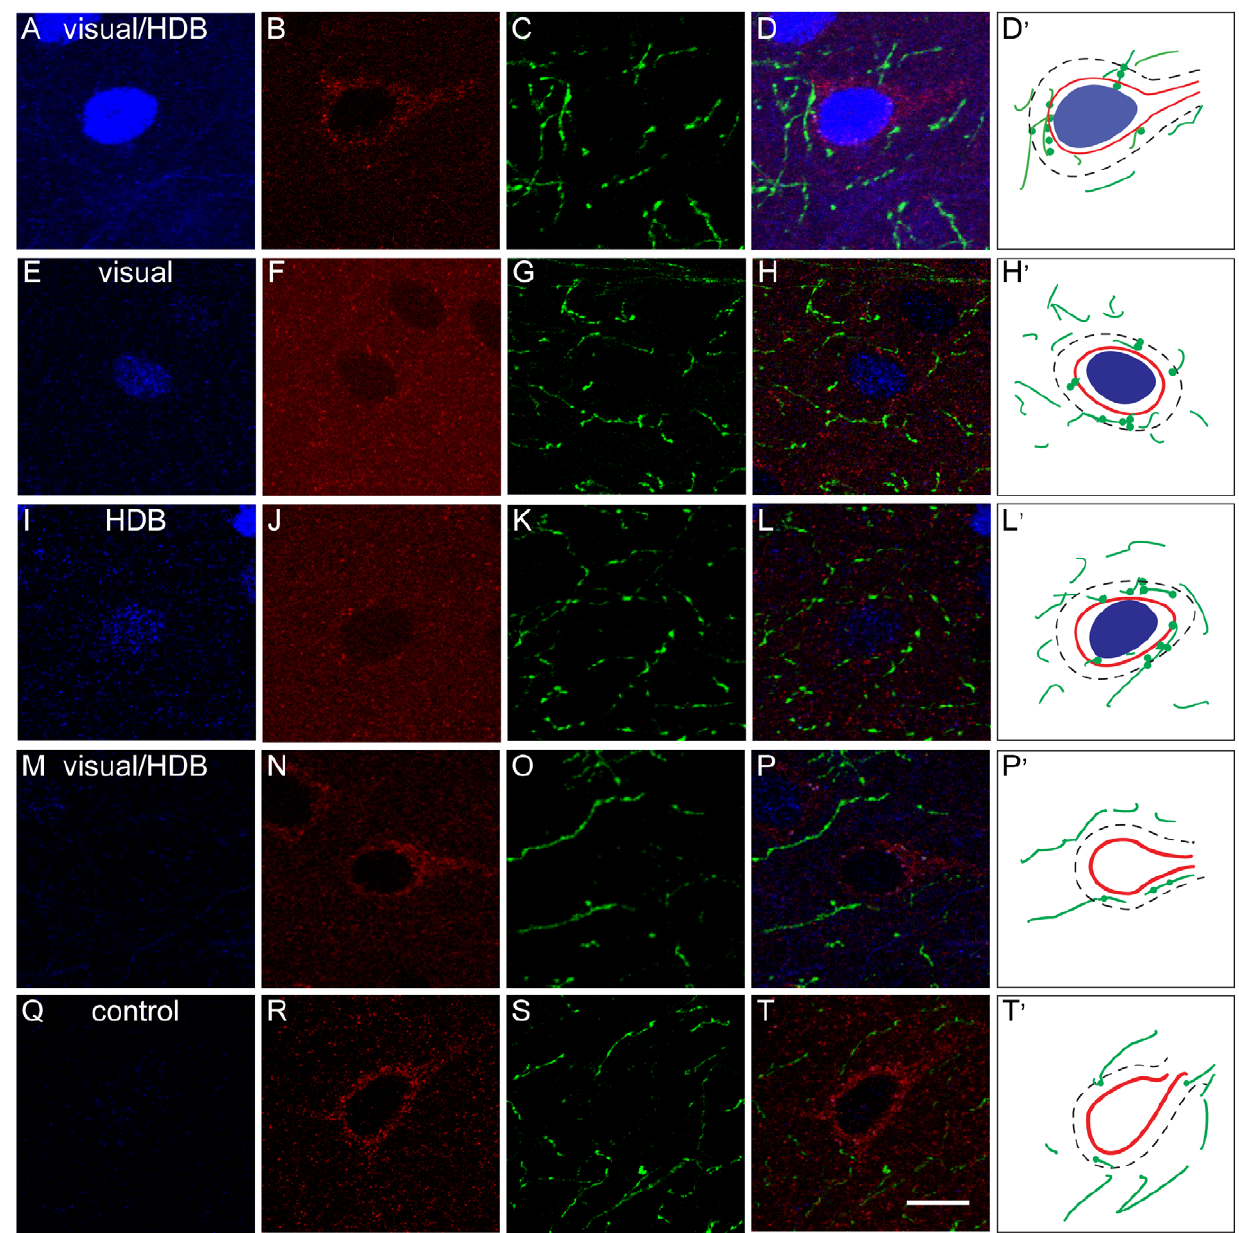
Figure 3. Evaluation of ChAT + varicosity density on fiber segments within microproximity of activated or nonactivated pyramidal cells. Representative examples of projection images of triple immunostaining for c-Fos (blue), GluT(EAAC1) (red) and ChAT (green) in layer V of the mPFC (A–P) of ChAT + varicosity in microproximity of activated pyramidal cells in visual/HDB stimulation group, visual stimulation only group, and HDB stimulation only group (the three top panels), and for ChAT + varicosity in microproximity of nonactivated pyramidal cells in the visual/HDB stimulation group and the control group (the bottom two panels) D’,H’,L’,P’, T’: Drawing of ChAT + fibers (green lines) within 3 m m microproximity (dashed line) of c-Fos + pyramidal cells (red perimeter with a blue nucleus) or non-activated pyramidal cells (red perimeter without blue nucleus) in layer V of the mPFC. Representative images were taken from IL and PrL. ChAT + varicosities (illustrated by dots on the green ChAT + fibers) were quantified on fiber segments within 3 m m microproximity of pyramidal cells. Note that an increased density of varicosities was seen in segments in microproximity of activated cells compared to non-activated cells. Abbreviations: ChAT: choline acetyltransferase; GluT(EAAC1): glutamate transporter; Cg1: cingulate cortex; IL: infralimbic cortex; mPFC: medial prefrontal cortex; PrL: prelimbic cortex. Scale bar: 10 m m.